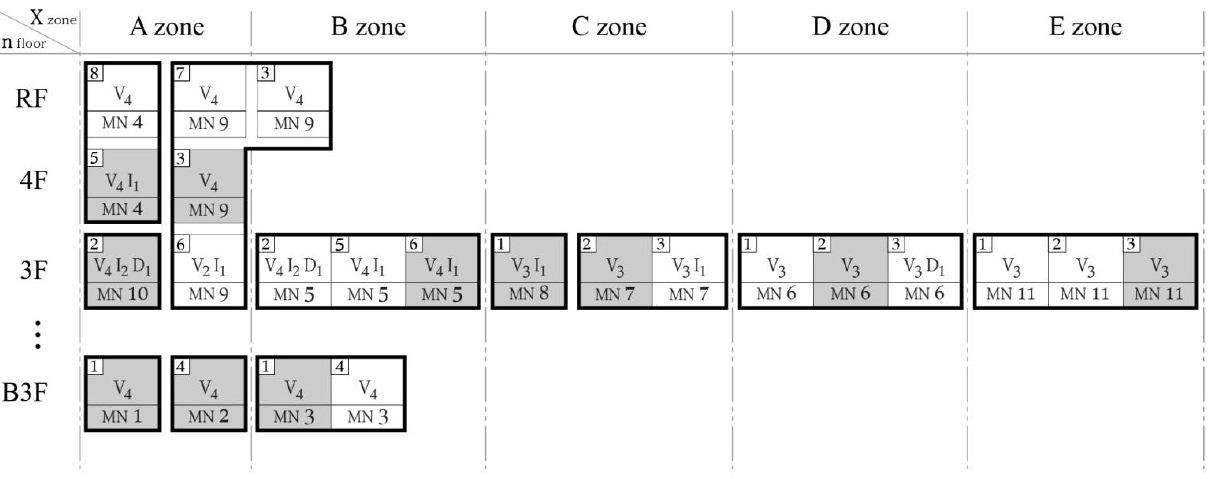
Figure 11. Simple notation for